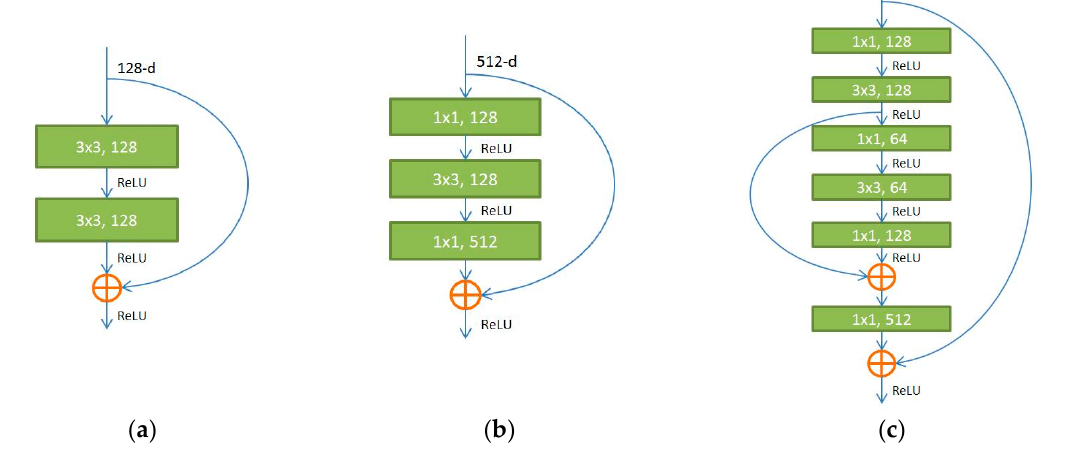
Figure 2. Residual building blocks. ( a ) Plain identity shortcut; ( b ) Bottleneck; ( c ) Residual in Residual (RiR). ( a , b ) are adopted in the original FCRN-50 and FCRN-101.